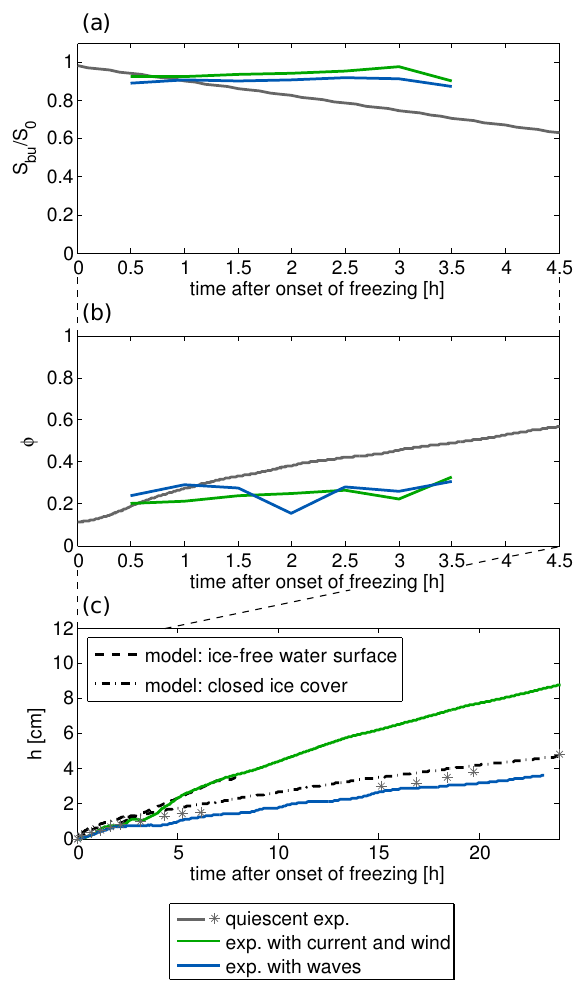
Fig. 9. (a) Temporal evolution of the bulk salinity normalised with the initial salinity of the water as an average over all experiments of each setup. (b) Temporal evolution of the solid fraction as an aver- age over all experiments of each setup. In case of the experiments with waves and with current and wind the values shown are averages of the two reliable methods (calorimeter and volume). (c) Temporal evolution of the measured and modeled ice thickness for experi- ments with different general setup at an air temperature of − 15 ◦ C. Color coding of the experiments corresponds to the legend at the